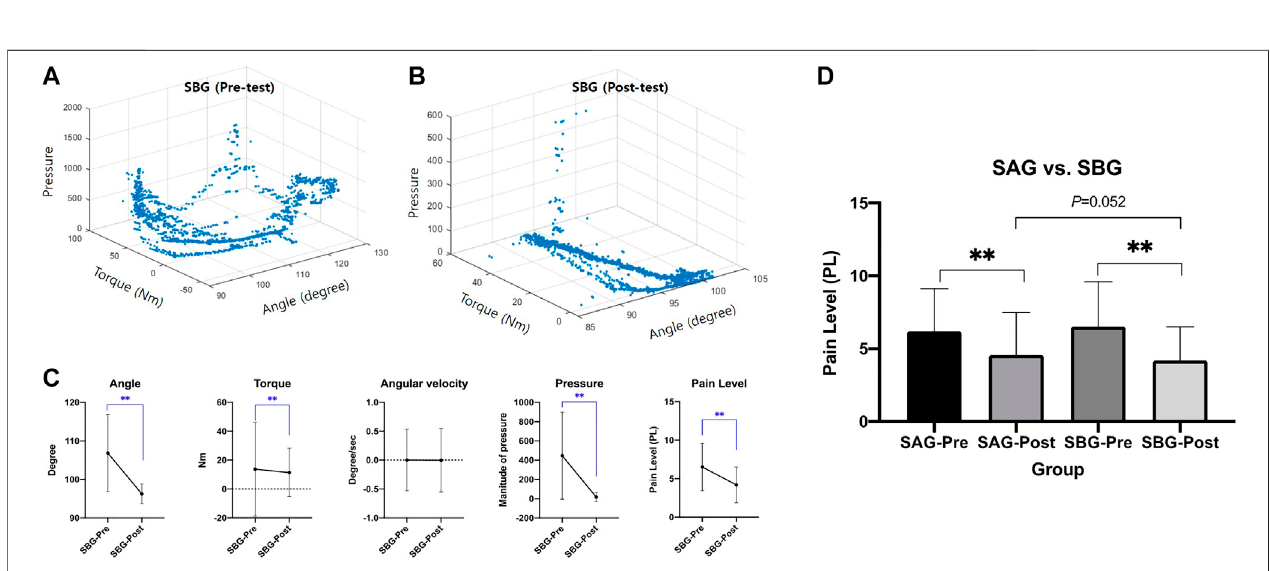
FIGURE 10 | Results of CaTARo with visual-based feedback: (A, B) are the examples of scatterplot of quantitative data (angle, torque, and pressure) from SBG (student #3) in (A) pretest and (B) posttest; (C) comparison result of statistical analysis of parameters as angle, torque, angular velocity, pressure, and pain level; (D) comparison result between SAG (graph-based) and SBG (visual-based). * p 0.05 and ** p 0.001.